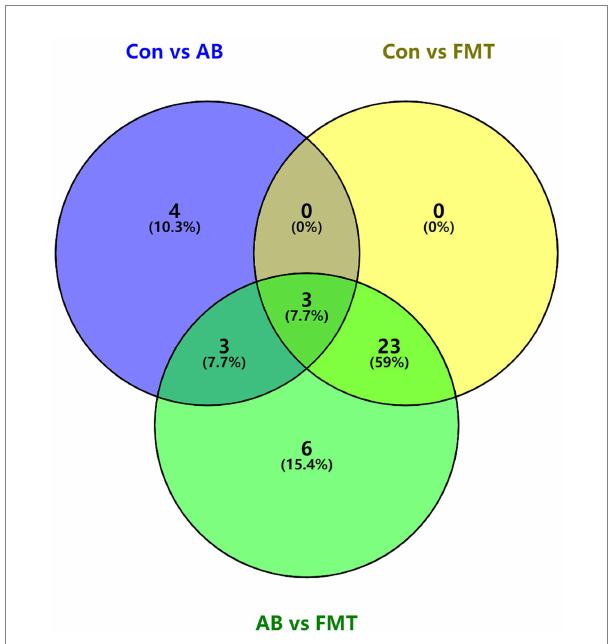
FIGURE 9 Venn diagram of shared and unique taxa at the genus level among Con, AB and FMT groups. The numbers of shared and unique taxa in the three pairwise comparison groups are shown based on the operational taxonomic units. Con, Control group; FMT, fecal microbiota transplantation group; AB, antibiotic group; DC, donor